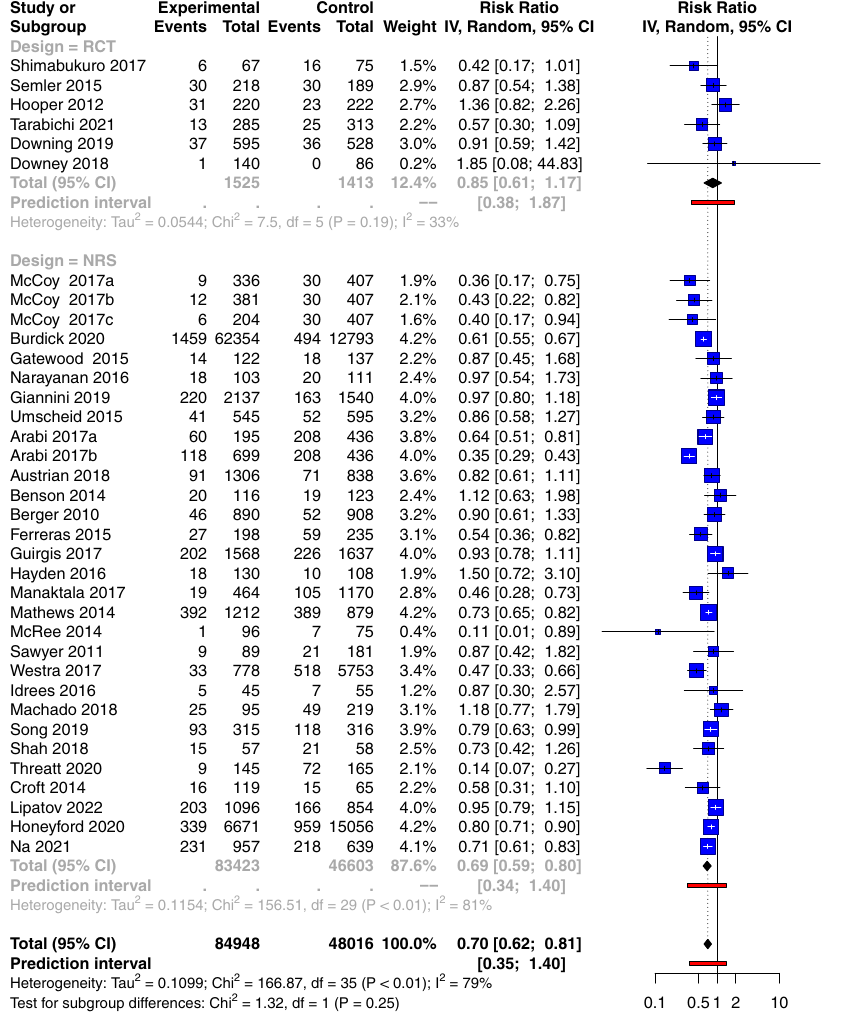
system were performed. The study protocol was registered in the International Prospective Register of Systematic Reviews (PROSPERO: CRD42022299219).